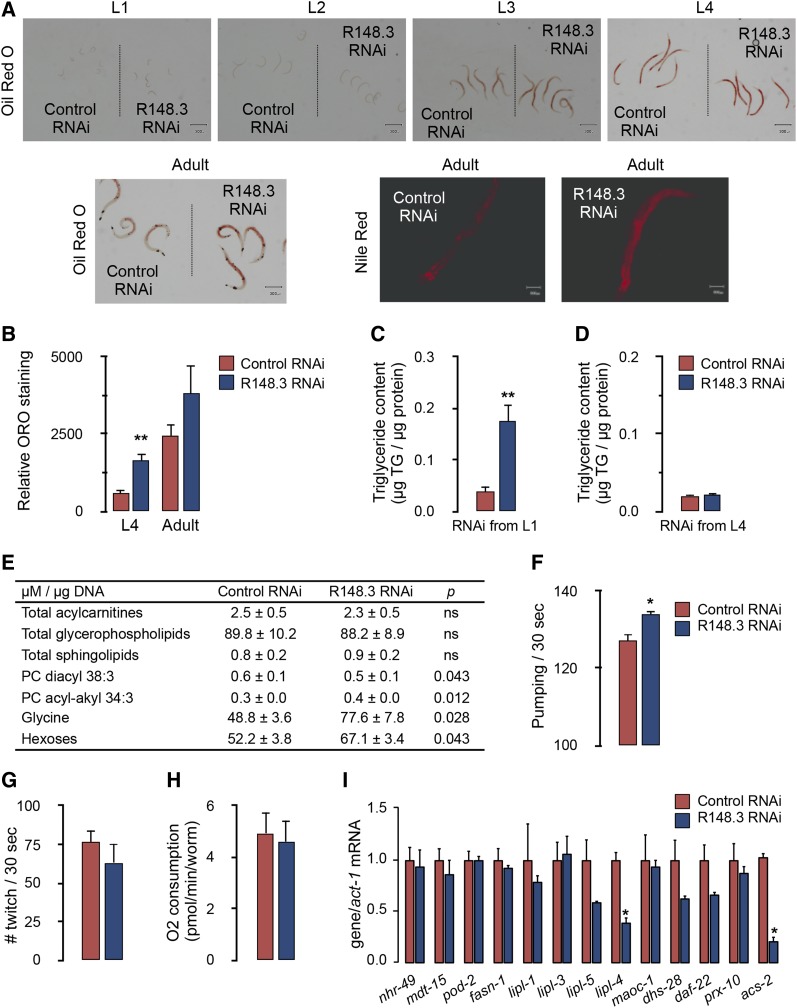
Loss of R148.3 increases triglyceride accumulation. (A) Oil red O and Nile Red staining of N2 worms fed either empty L4440 vector (control) or R148.3 RNAi starting at stage L1. Animals were assessed at all developmental stages and in adulthood. (B and C) Quantitative analysis of Oil Red O staining (B), and whole-body triglyceride content (C) of worms described in (A) and studied at L4 and adult stages. (D) Whole-body triglyceride content of worms fed either empty L4440 vector (control) or R148.3 RNAi starting at stage L4/young adult and studied 8 d later. (E) Metabolomic analysis of lipid species of worms described in (C). (F–I) Pharyngeal pumping rates (F), twitching rates (G), oxygen consumption (H), and mRNA expression levels of lipid metabolism genes (I) of L4 worms described in (C). For all panels, * P < 0.05, ** P < 0.01. Assays were performed on at least four independent plates per group, each containing 100–200 worms.